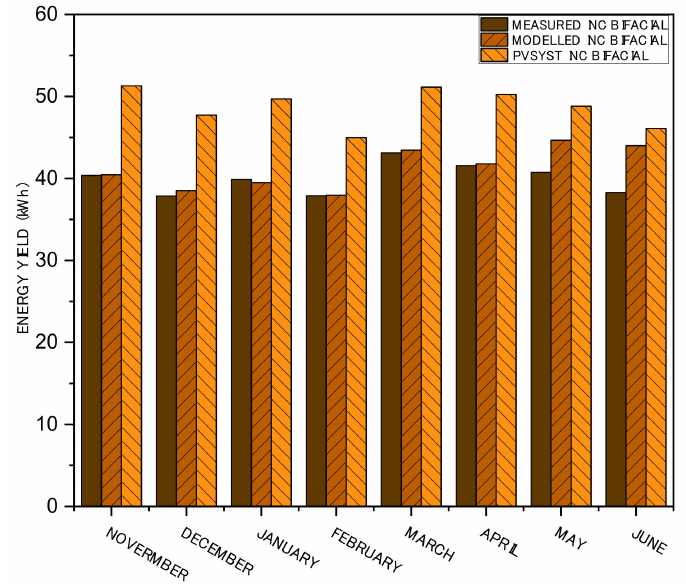
Figure 4. Measured, modelled, and PVsyst monthly energy yield of the tilted bifacial PV